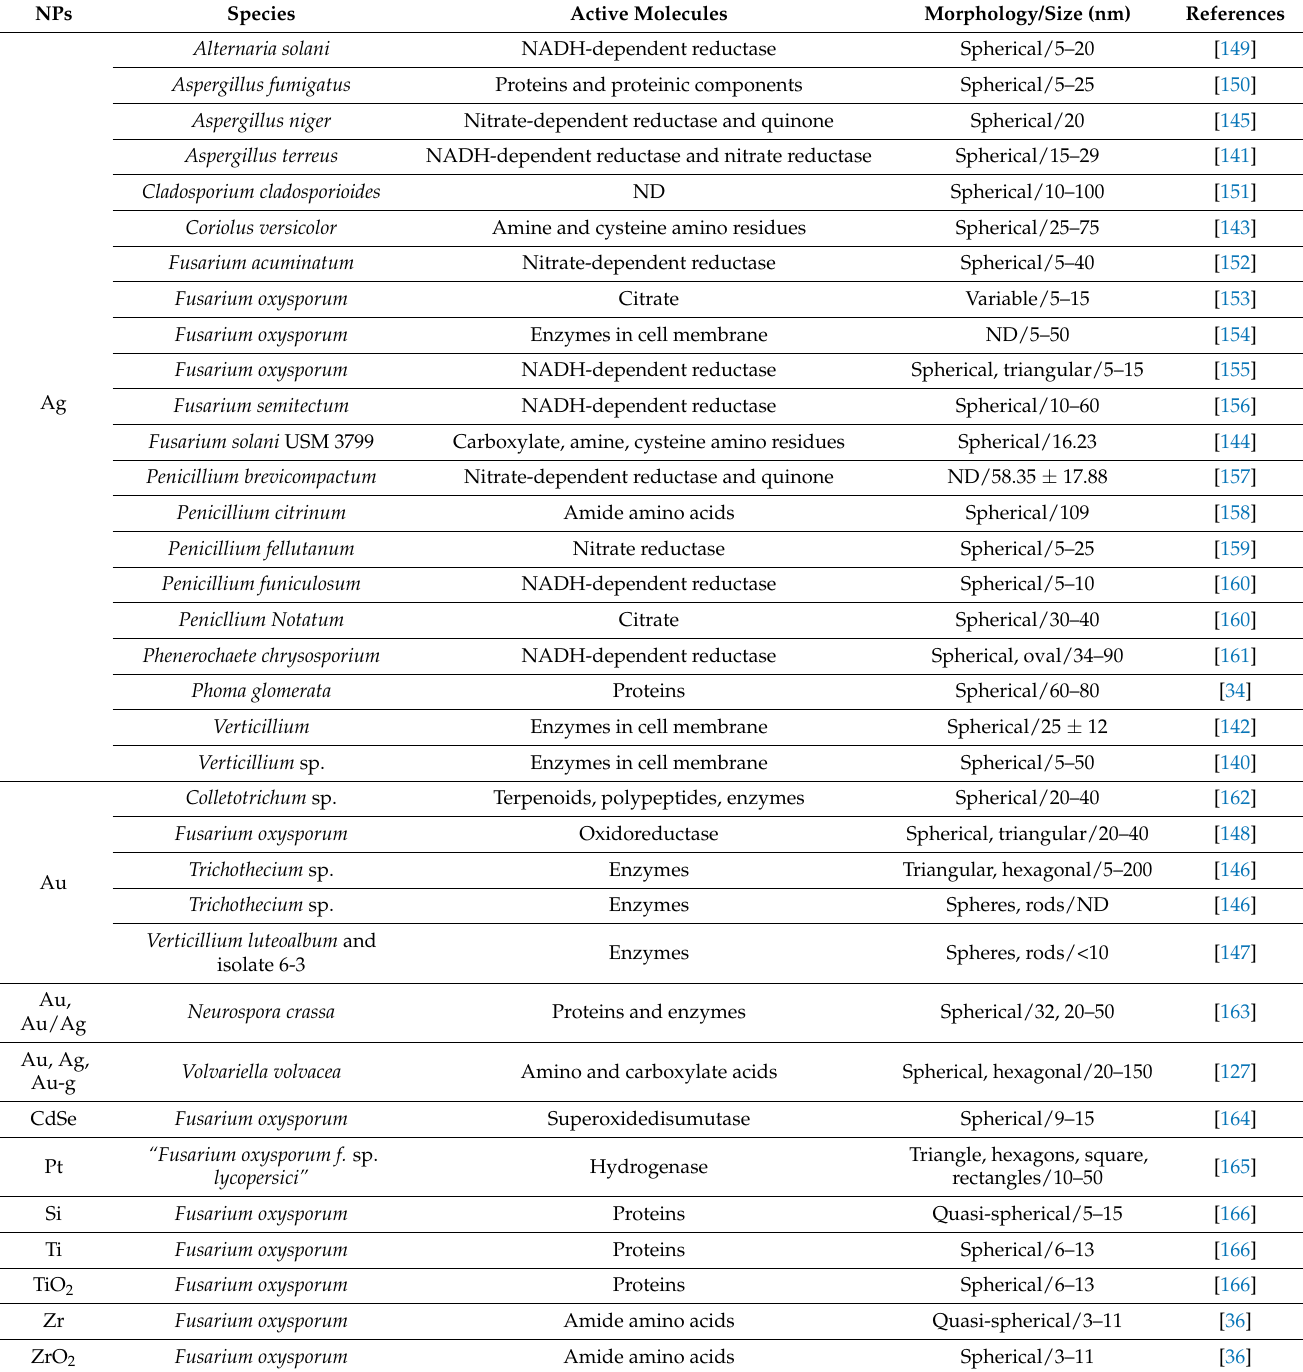
Table 3. Nanoparticles produced by